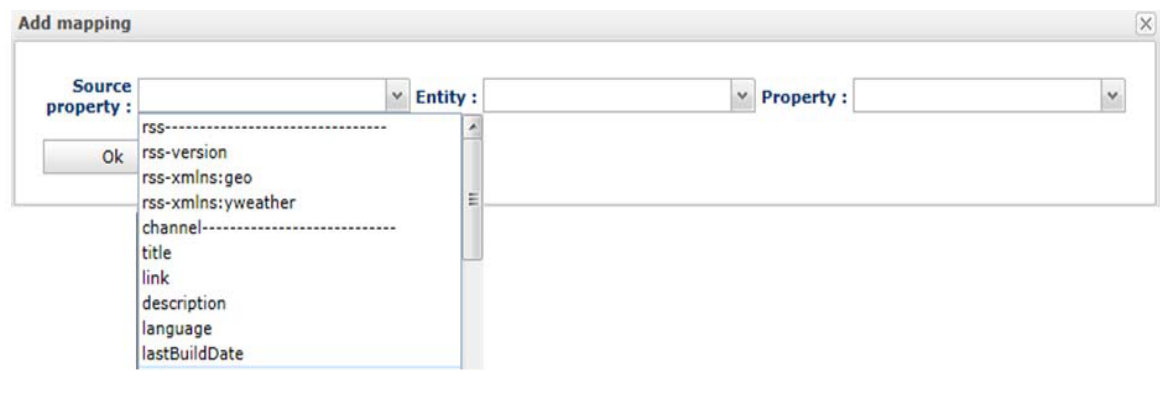
Figure 7. Mapping